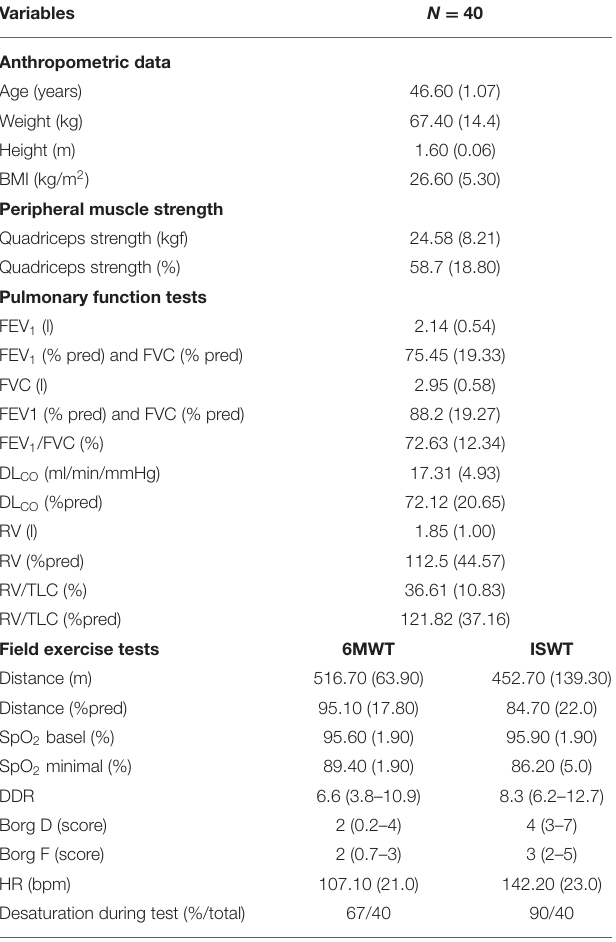
TABLE 1 | Baseline anthropometrical, clinical, and functional characteristics of the patients with LAM. Variables N =